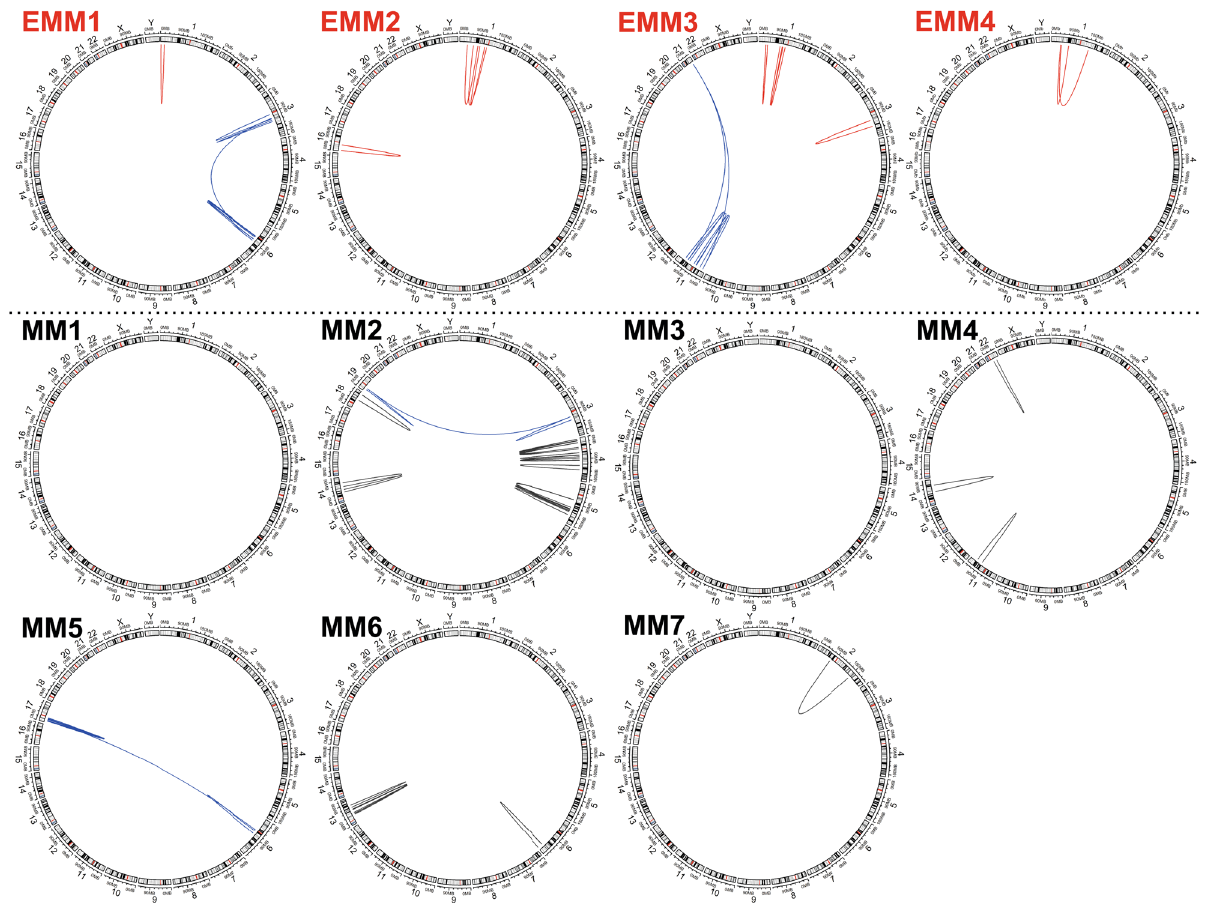
Figure 4. Intrachromosomal rearrangements identified in EMM (red lines) and MM (black lines) patients. Blue lines represent complex rearrangements including